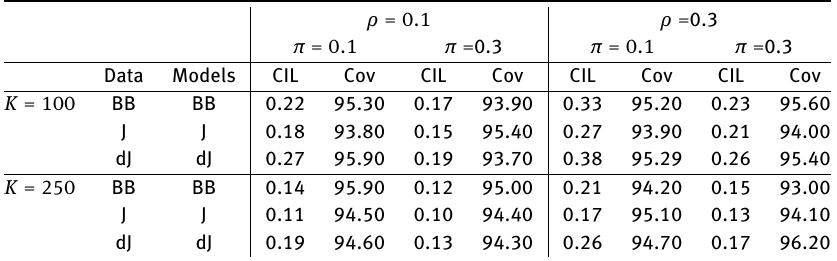
Table 3: Small cluster simulations: Confidence interval length (CIL) and empirical coverage (COV) of two-sided PLCI for ρ with a nominal 95% confidence level under beta-binomial, Joe, and dJoe